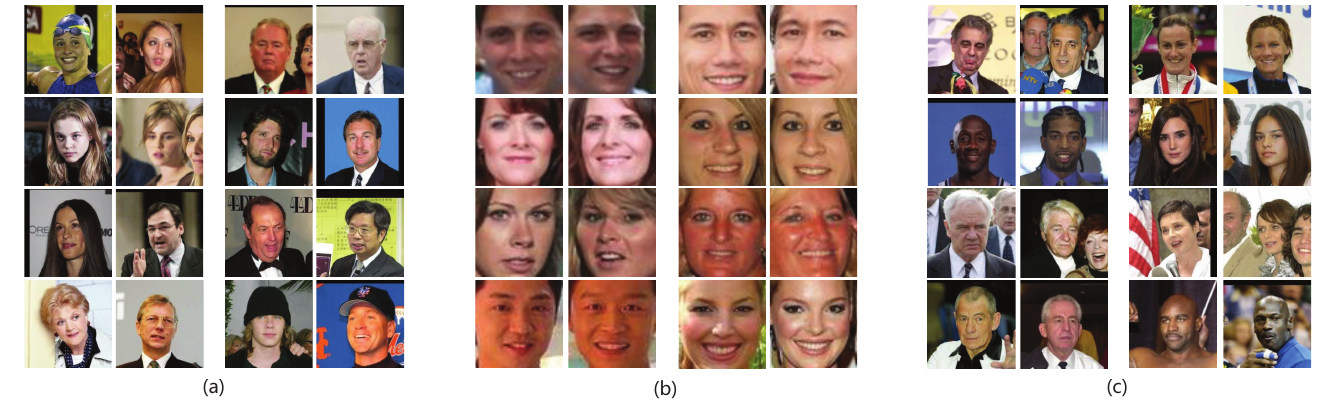
Figure 2. Negative pairs of face images sampled from the LFW, FGFV and FGLFW datasets. ( a ) LFW, ( b ) FGFV, ( c ) FGLFW.